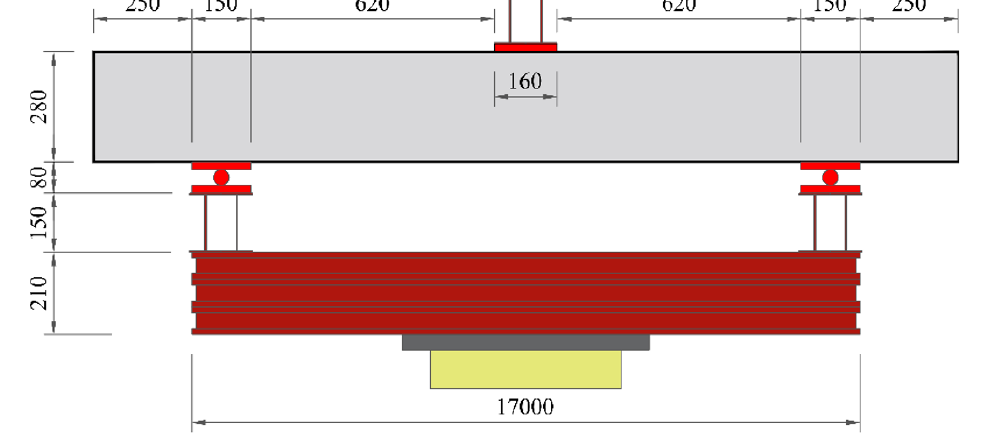
Figure 3. Testing setup